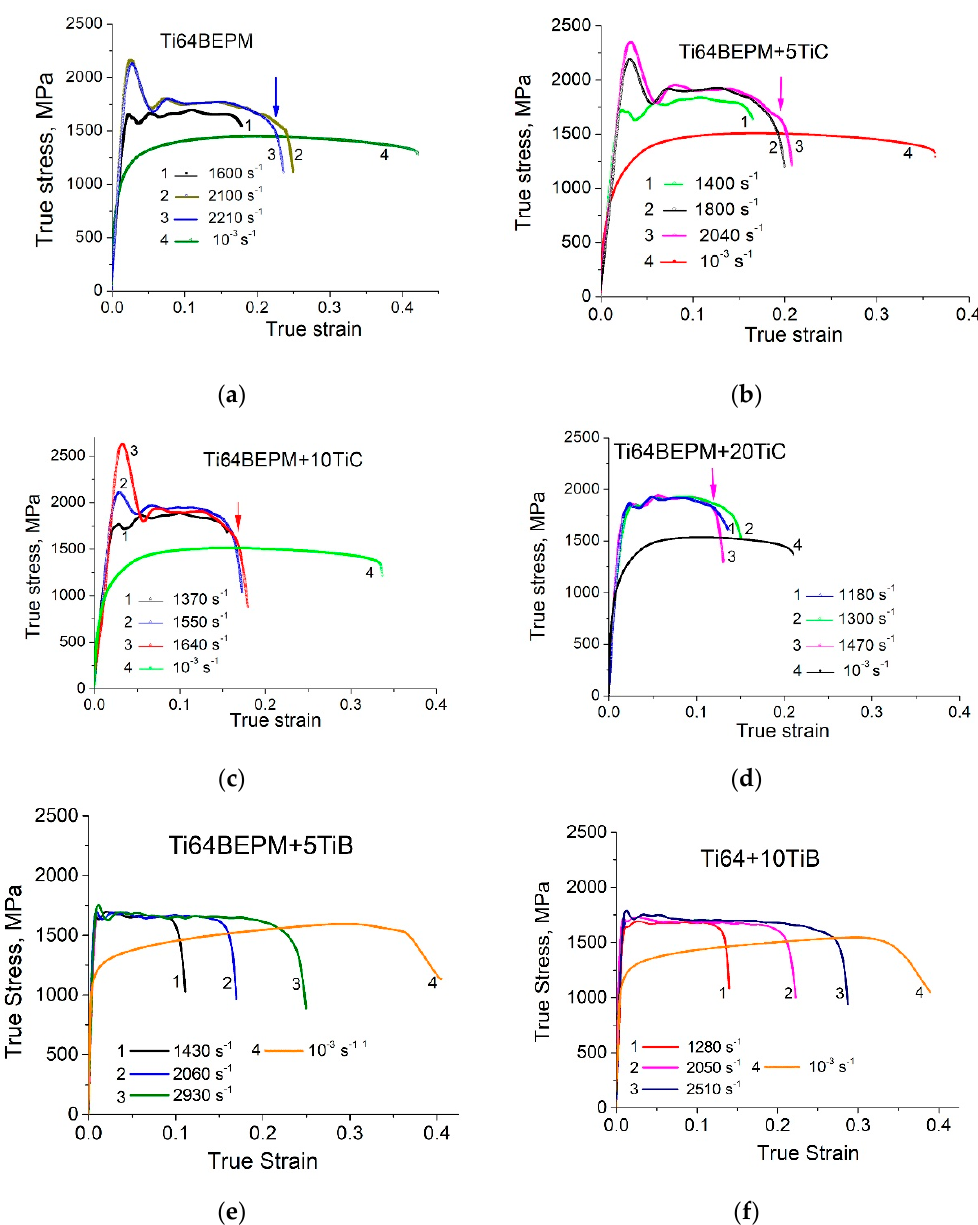
Figure 5. Typical examples of true-stress–true strain curves for SHPB (##1–3), and QSC (# 4) tests obtained with: ( a ) Ti64BEPM, ( b ) Ti64BEPM + 5TiC, ( c ) Ti64BEPM + 10TiC, ( d ) Ti64BEPM + 20TiC, ( e ) Ti64BEPM + 5TiB, and ( f ) Ti64BEPM + 10TiB samples tested at different rates. Arrows (their colors match the colors of the relevant curves) indicate the moments of samples’ cracking.